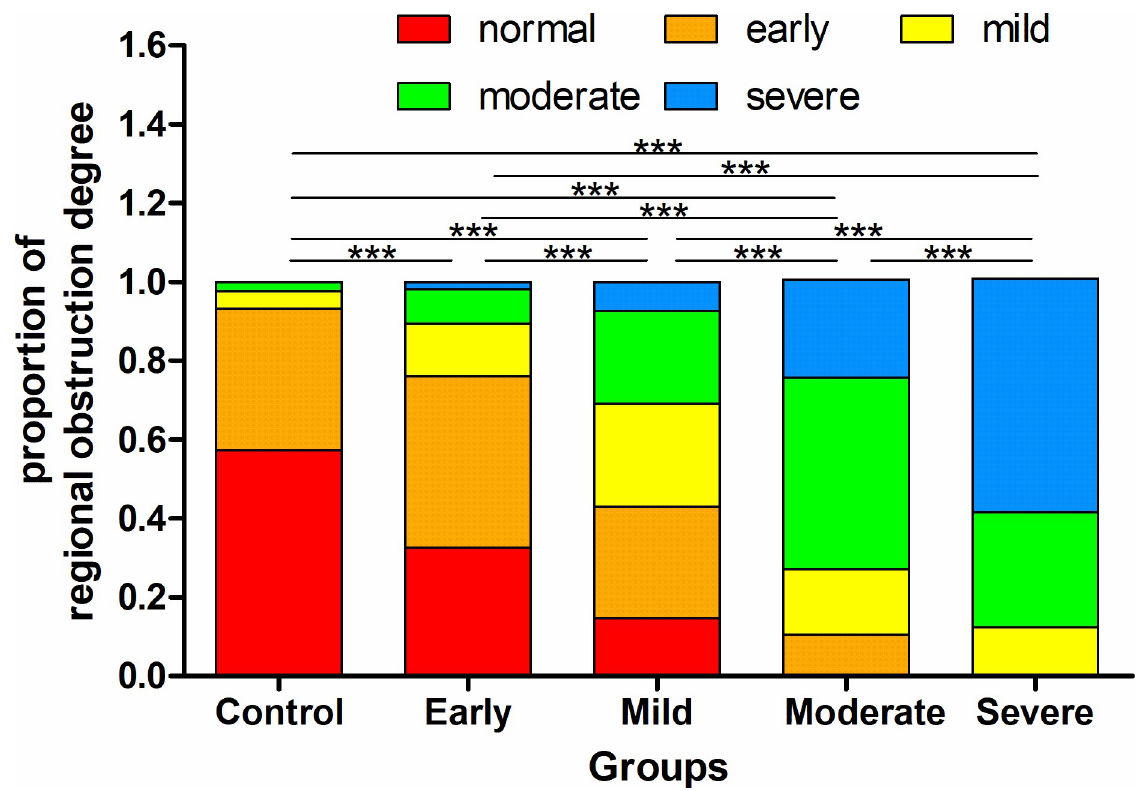
Fig 8. The proportion of regional degree in all the four-quadrant ROIs of each group. Significant differences among the groups are indicated by ��� p < 0.005.